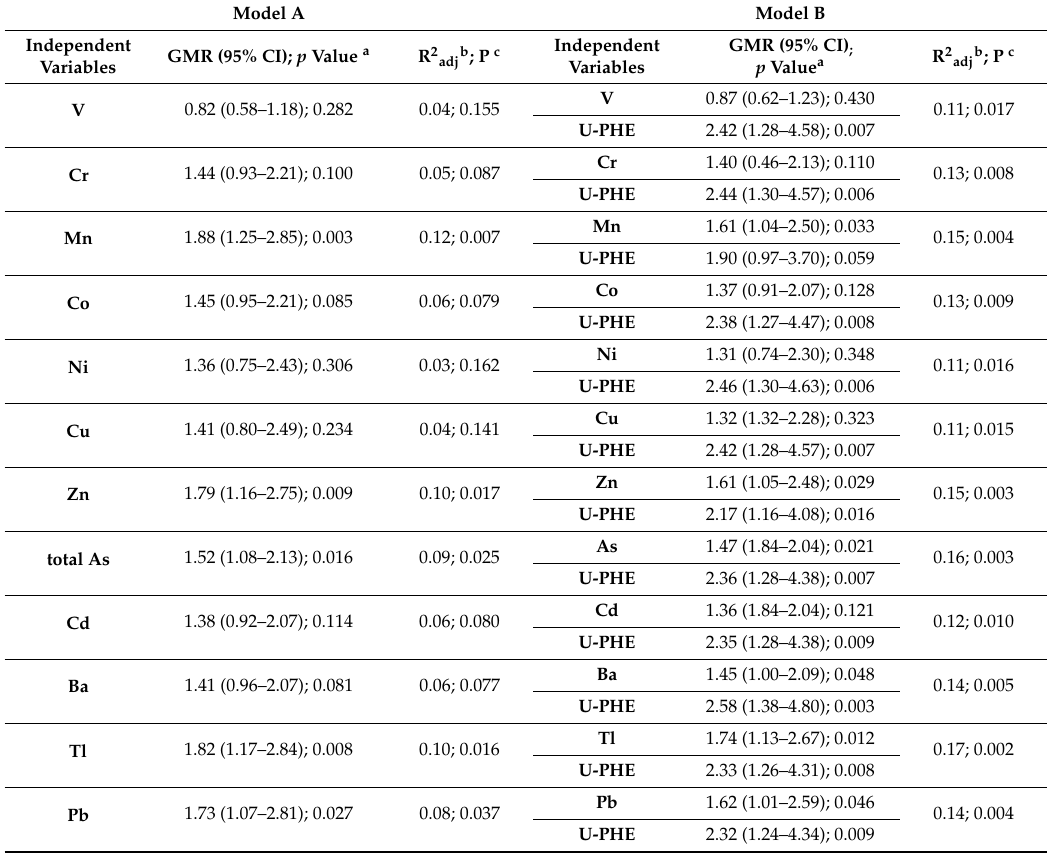
Table 2. Results of multiple linear regression analyses for predicting urinary levels of 8-oxodG as a function of metal exposure only (Model A) and as a function of co-exposure to metal and polycyclic aromatic hydrocarbons (PAHs), (Model B). Independent variables were the urinary levels of each single urinary metal in Model A, and the urinary levels of each single urinary metal plus urinary phenanthrene (U-PHE) in Model